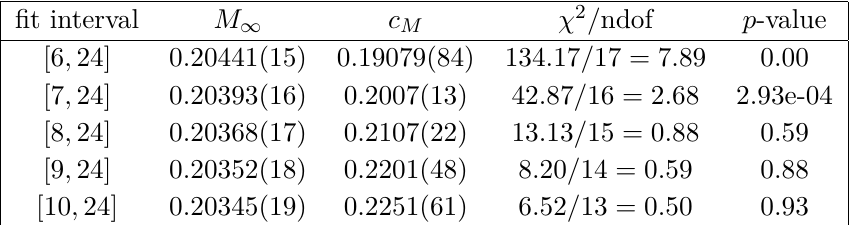
Table 3. Results, obtained from the single-particle mass fits.